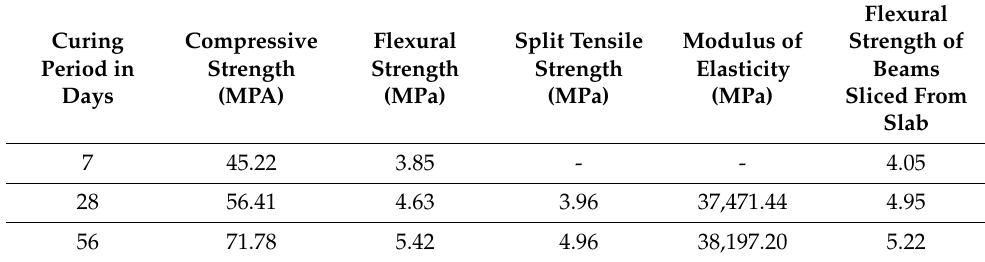
Table 7. Hardened properties of M10 mix [132].